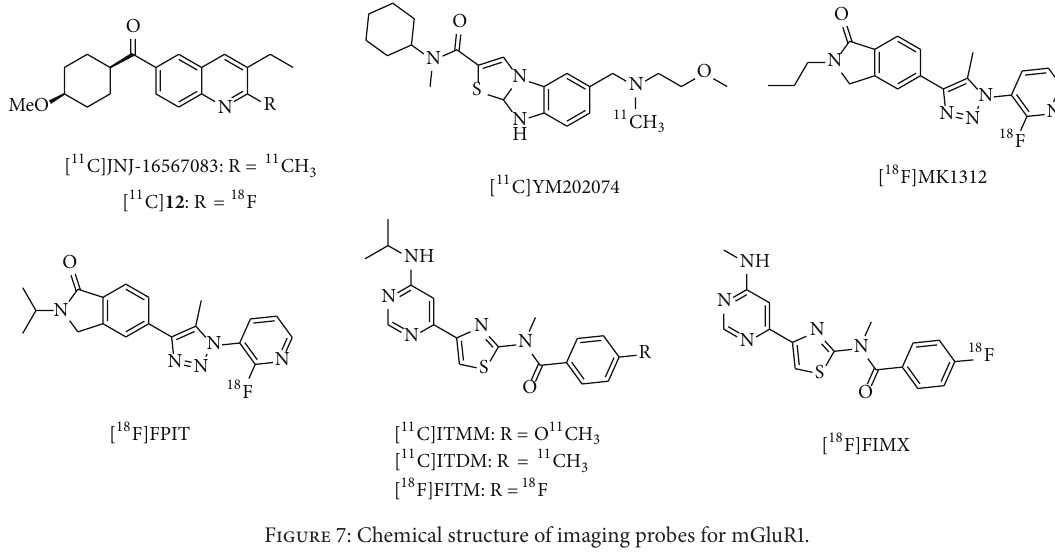
high-affinity, selective mGluR1 ligand ( 𝐾 𝑖 = 4.8 nM for rat mGluR1) with lower lipophilicity than JNJ-16567083 (log D = 2.7 versus 3.38). Although [ 11 C]YM-202074 showed in